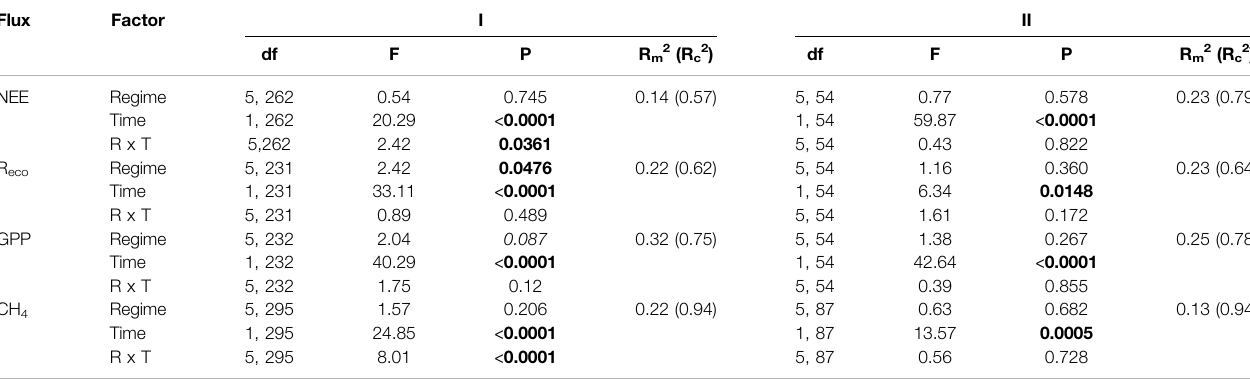
TABLE 2| Outcome oflinearmixedeffectsmodels testing the in fl uence ofprecipitation regime (Regime, R) and samplingdate (Time, T) onratesofnetecosystemexchange (NEE), ecosystem respiration (R eco ), gross primary productivity GPP), and methane (CH 4 ), during the resistance phase (I, week 1 – 10), and resilience phase (II, week 10 –